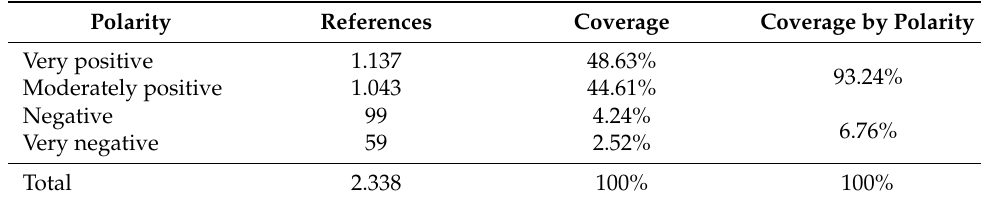
Table 1. Sentiment analysis